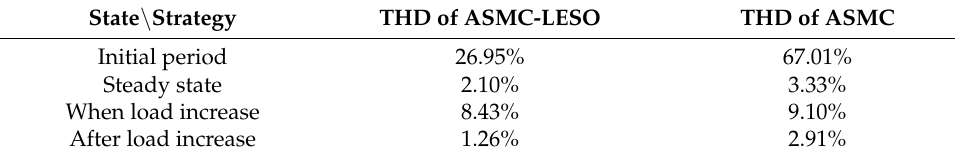
Figure 12. Comparison curve of output chattering of the ASMC-LESO and ASMC.